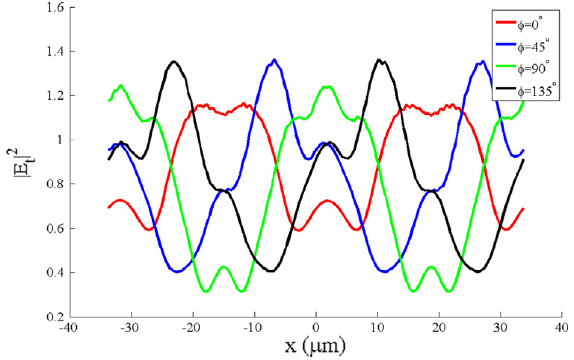
Figure 16. The simulated result of the intensity ~ E t (cid:9) (cid:9) (cid:9) (cid:9) 2 vs. spatial position x for various orientation angles / . Since the reconstruction of the plane wave is not perfect, the intensity distribution is not sinusoidal as in the theoretical result. However, the relative positions of the peaks and troughs match well with those of the theoretical